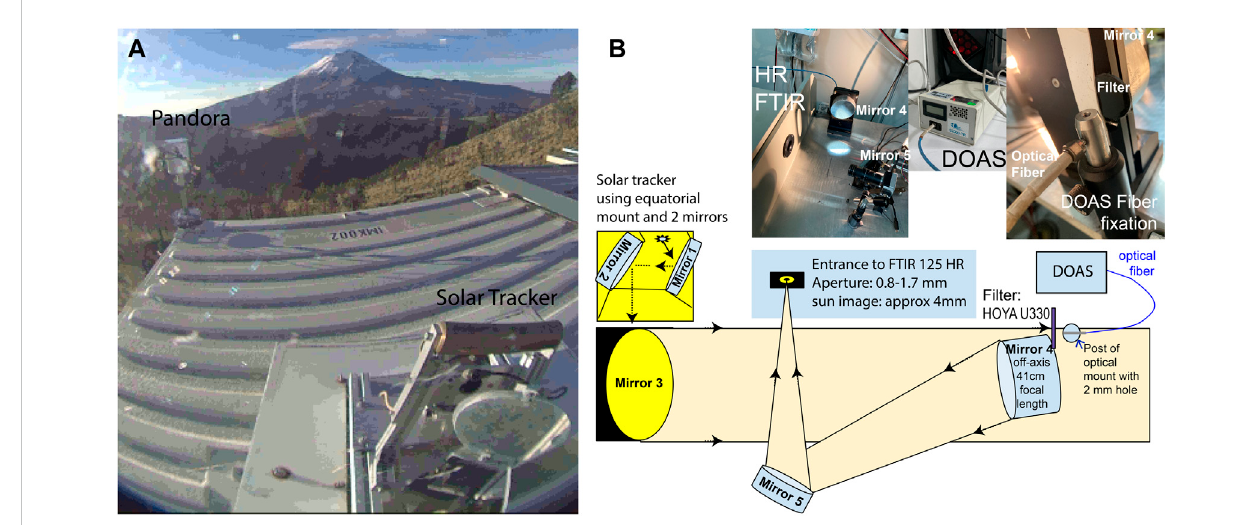
FIGURE 1 Set-up of the Pandora, HR-FTIR and S2000 DOAS instruments at the ALTZ station. (A) Global view of the instruments installed on the roof of the ALTZ station. (B) Instrumental set-up for the combined DOAS-FTIR measurements.